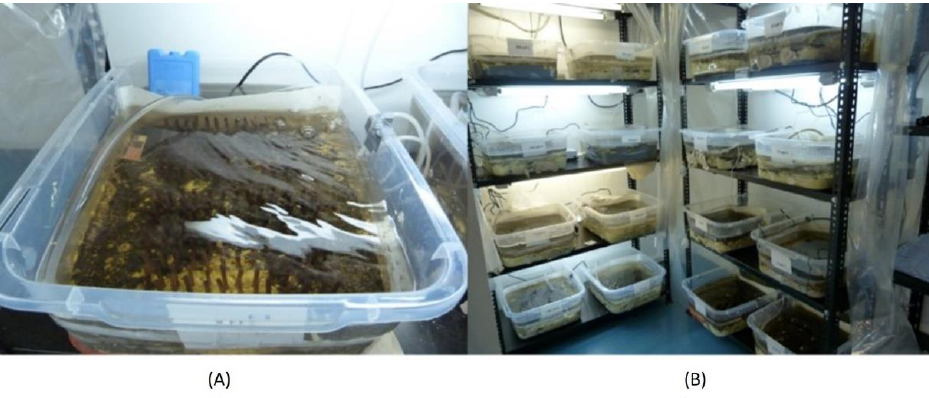
Figure 1. ( A ) Microcosm design. ( B ) Distribution of the microcosm in the experimental room under controlled light and temperature conditions.